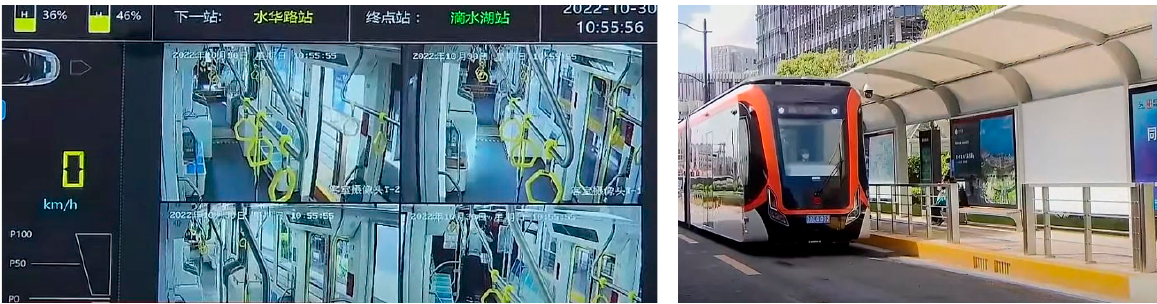
Figure 22. Train/ferry powered by Hydrogen fuel cells in German/China [51,57].